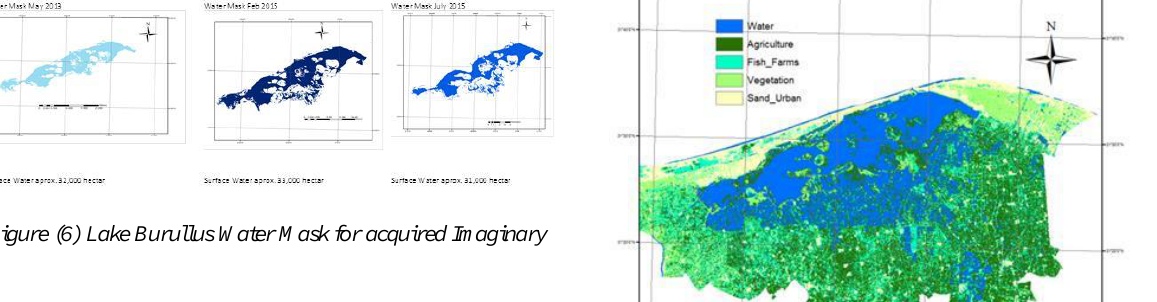
Figure (5) NDVI Map of Lake Burullus (July 2015)